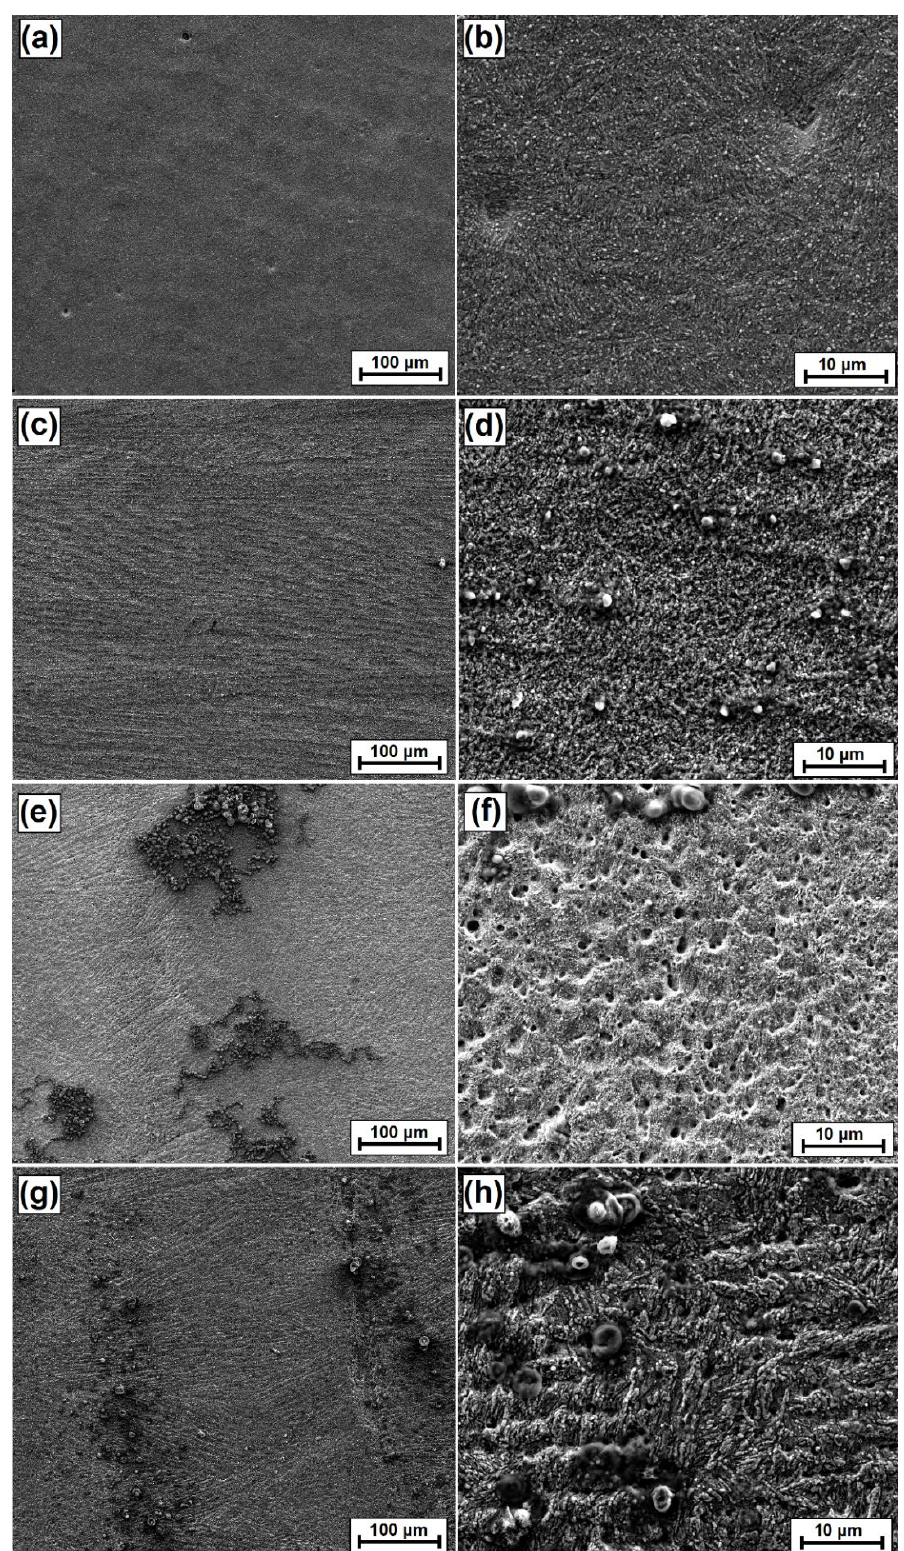
Figure 16. Surface images obtained after the corrosion resistance test: ( a ) substrate after hardened and tempered processes, ( b ) magnification of the substrate after hardened and tempered processes, ( c ) coating produced by 500 W, ( d ) magnification of the coating produced by 500 W, ( e ) coating produced by 900 W, ( f ) magnification of the coating produced by 900 W, ( g ) coating produced by 1100 W, ( h ) magnification of coating produced by 1100 W. All photos were taken in SE contrast, in high vacuum at a voltage of 10 kV.